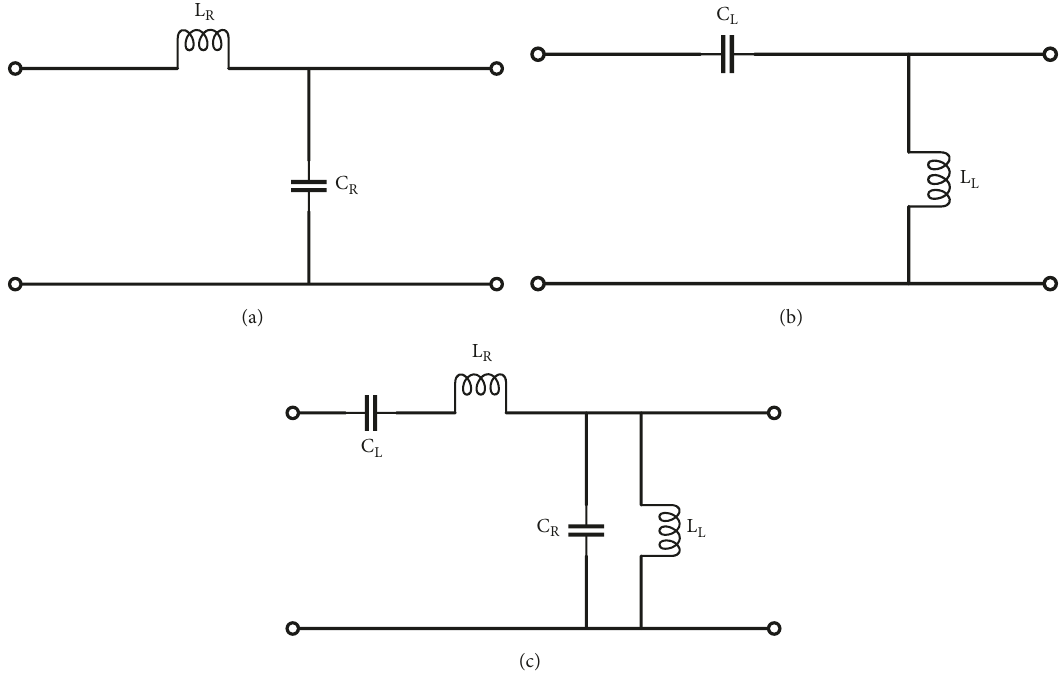
Figure 5: Equivalent schematicdiagram. (a) Equivalent schematicdiagram of PRH. (b) Equivalent schematicdiagram of PLH. (c) Equivalent schematic diagram of